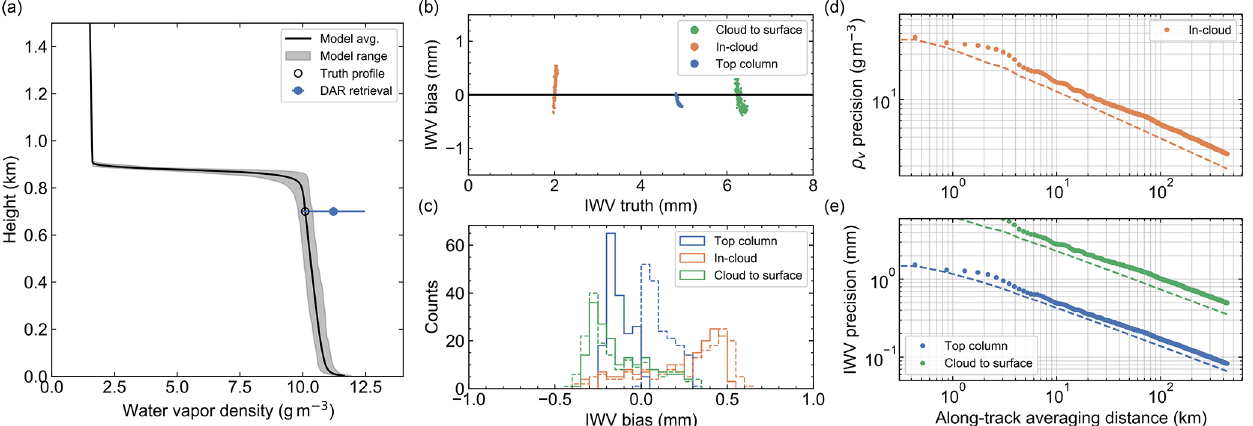
Figure 11. DYCOMS-II DAR retrieval results. Because of the limited vertical extent of cloud volume, every horizontal grid cell features just a single in-cloud profiling retrieved value and identical upper- and lower-tropospheric column lengths. All panels have identical descriptions to those in Fig.